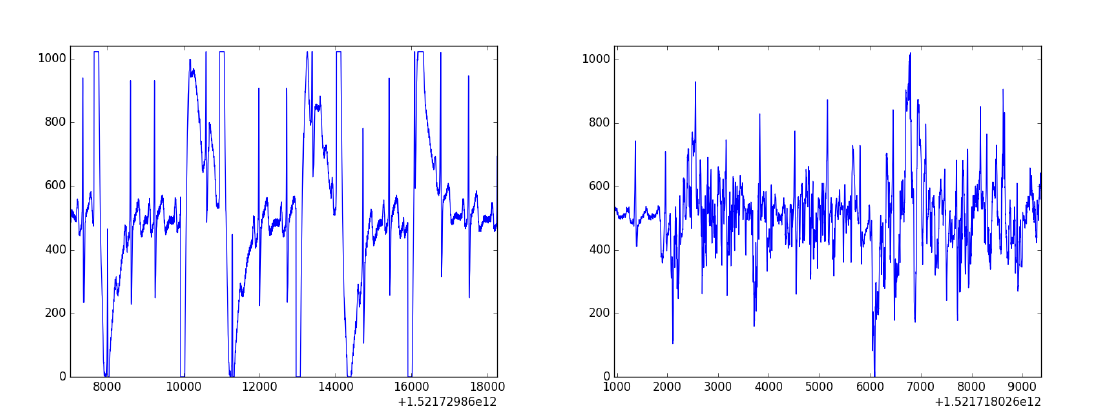
Figure 10. Two samples of ECG signal. R peaks are visible, but are surrounded by a large amount of noise.